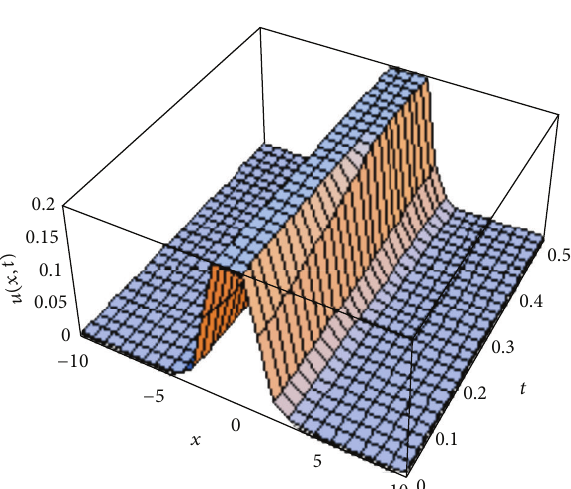
Figure 3: Approximate solution for 𝛼 = 1 and 𝛽 = 0.9